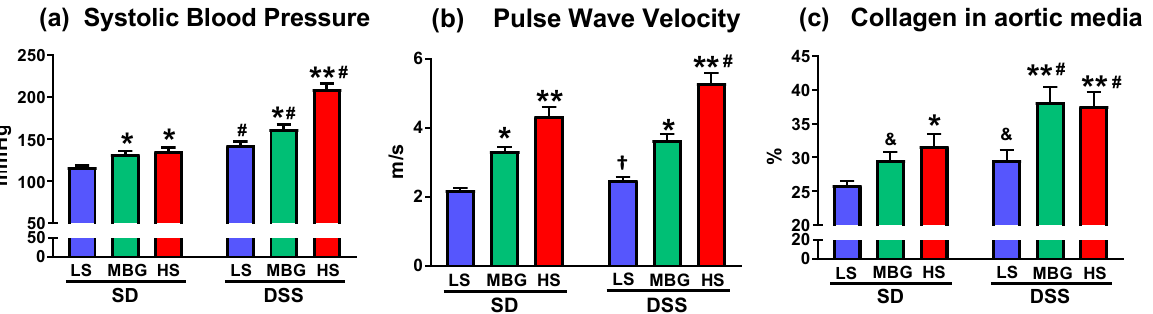
an aPWV increase in both strains vs. LS (red bars vs. blue bars, Figure 4a,b). Notably, the hypertensive effect of HS intake was more pronounced in DSS-HS than in SD-HS rats (Figure 4a; Table 1), reaching values for SBP over 200 mmHg, which is expected in the DSS rats upon HS intake, as was demonstrated in previous studies [1,3]. Both SD and DSS rats, which were administered MBG or an HS diet, exhibited higher collagen abundance in the aortic wall vs. the LS controls (Figure 4c), which is in congruence with aPWV changes (Figure 4b). The representative photomicrographs of aortae from each experimental group are presented in Figure 5. Notably, that the difference in aortic collagen in SD-MBG vs. SD-LS, and in DSS-LS vs. SD-LS was borderline significant by two-way ANOVA analysis (Figure 4c). Figure 4. Effect of administration of MBG and high-salt (HS) dietary intervention on systolic blood pressure ( a ), pulse wave velocity ( b ), and collagen abundance in aortic wall ( c ). Bars represent mean ± SEM. Two-way ANOVA followed by Holm-Sidak’s multiple comparison post hoc test: * p < 0.05, ** p < 0.01 vs. LS groups for both SD and DSS rats; # p < 0.01 DSS vs. SD; & 0.05 < p < 0.1, vs. SD-LS. Two-tail unpaired t -test: † p < 0.05, DSS-LS vs. SD-LS (pulse wave velocity). Experimental group: LS, low salt for 8 weeks (blue bars); MBG, administration of MBG for 4 weeks (green bars); HS, high salt for 8 weeks (red bars); SD, Sprague–Dawley rats; DSS, Dahl salt-sensitive rats. Plasma MBG was similar in both SD-LS and DSS-LS groups on an LS diet and in- creased after MBG or HS intake in both SD and DSS groups vs. LS controls (Table 1). Plasma MBG doubled in DSS-MBG rats after MBG administration and increased 2.8-fold after HS diet intervention in DSS-HS vs. DSS-LS rats. In the SD rats, plasma MBG increase was moderate in SD-MBG and SD-HS vs. SD-LS (by t -test, Table 1). Urine MBG excretion was similar in both SD-LS and DSS-LS groups. MBG administration moderately increased urine MBG in both SD-MBG and DSS-MBG vs. LS groups (by t -test). HS intake was asso- ciated with a more dramatic increase in urine MBG in both strains, i.e., with a three-fold increase in urine MBG in SD-HS rats vs. SD-LS rats, and with a six-fold increase in MBG in urine in DSS-HS vs. DSS-LS rats (Table 1). Interestingly, in the present study, brain MBG was 2.5-fold lower in DSS-LS rats vs. SD-LS rats, and significantly increased after MBG or HS administration in both strains vs. their LS controls (Table 1).